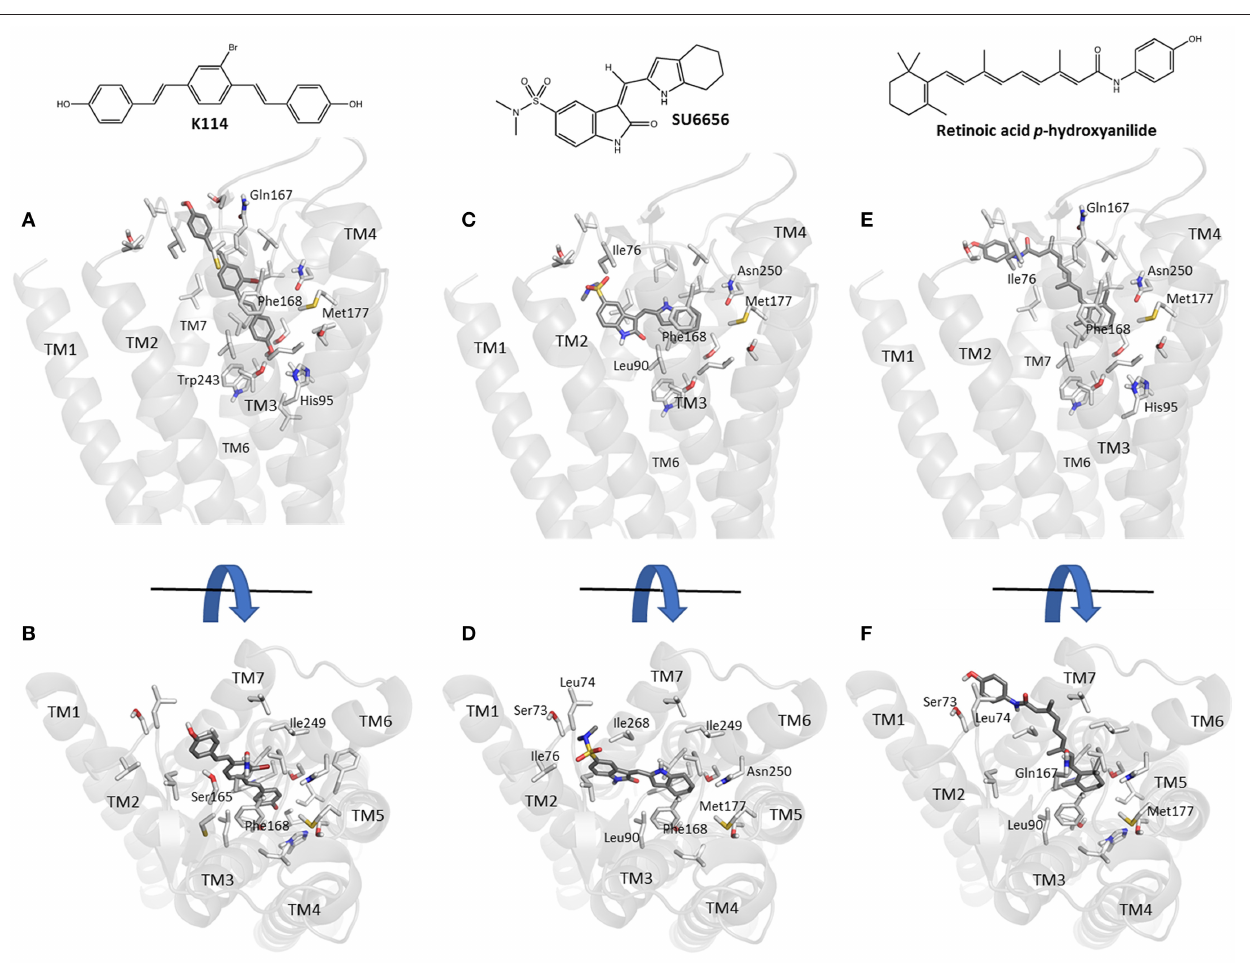
FIGURE 5 | Molecular modeling simulation of K114, SU 6656 and retinoic acid p -hydroxyanilide binding to the A 3 AR. A side-on (A,C,E) and top-down (B,D,F) view of the top scoring binding poses for K114, SU 6656 and retinoic acid p -hydroxyanilide (dark gray liquorice coloring) respectively, bound into our previously reported A 3 AR receptor homology model (Vernall et al., 2013). Previously identified amino acid side chain residues associated with the orthosteric binding pocket (Squarcialupi et al., 2013) are represented in light gray liquorice coloring and labeled alongside the TM loop regions for